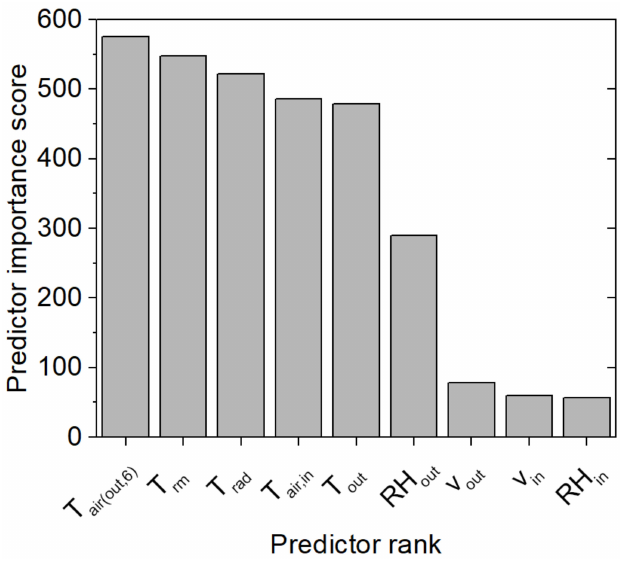
Figure 6. Univariate feature ranking for regression using F-tests.